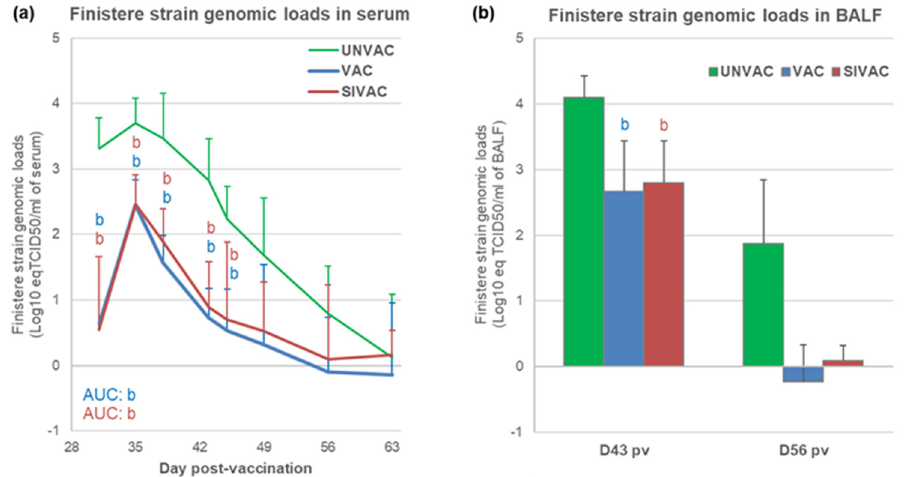
Figure 10. PRRSV1 Finistere strain genomic loads in ( a ) serum or in ( b ) BALF. Data are reported as the mean ( ± SD) of the results obtained from all piglets in each group. Different letters (b,c) indicate that the considered group (specified by its color) was significantly different from the UNVAC group (b) or from the VAC group (c) with p < 0.05. AUC: area under the curve. There is no significance c found in these graphs.